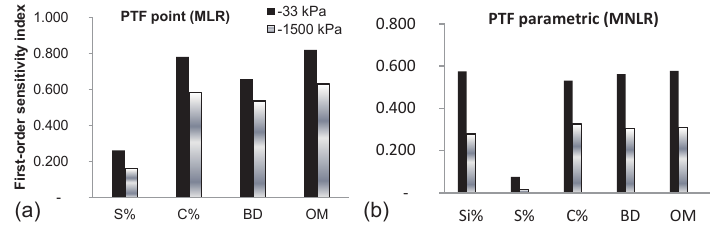
Figure 4. First-order sensitivity